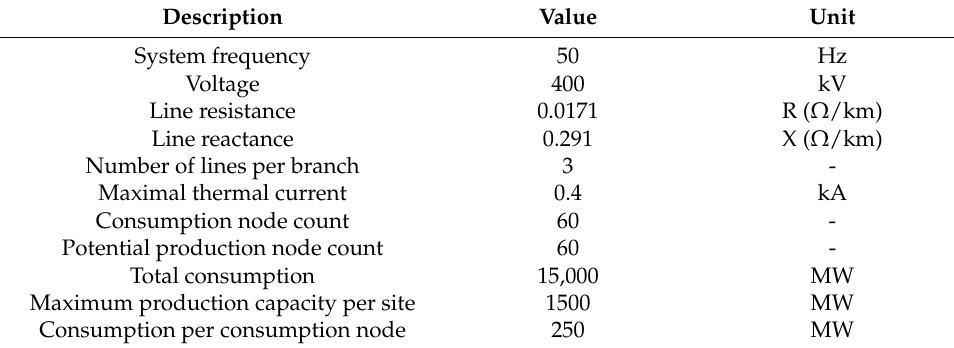
Table 2. Values used in the network power flow